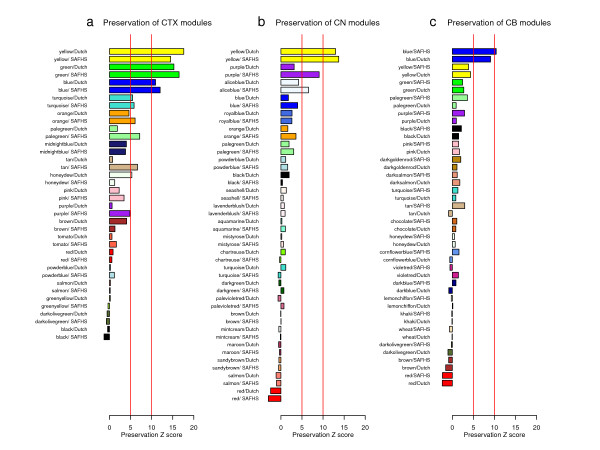
Studying the brain module preservation in human blood. The row bars correspond to brain co-expression modules found by Oldham et al. (2008). Modules are labeled by a color. For each module color, there are two horizontal bars which correspond to the module preservation Z statistics in the Dutch blood data and the SAFHS blood data, respectively. The two red vertical lines correspond to thresholds of moderate preservation (5) and strong preservation (10). Panel (a) shows that only three (yellow, green, and blue) out of 19 cortex modules showed strong preservation in both blood data sets. Panel (b) shows that only one (yellow) out of 23 caudate nucleus modules was strongly preserved in both blood data sets. Panel (c) shows that only one (blue) out of 22 cerebellum modules was strongly preserved in both blood data sets. In summary, only five modules from Oldham et al. (2008) show strong evidence of preservation in human blood.